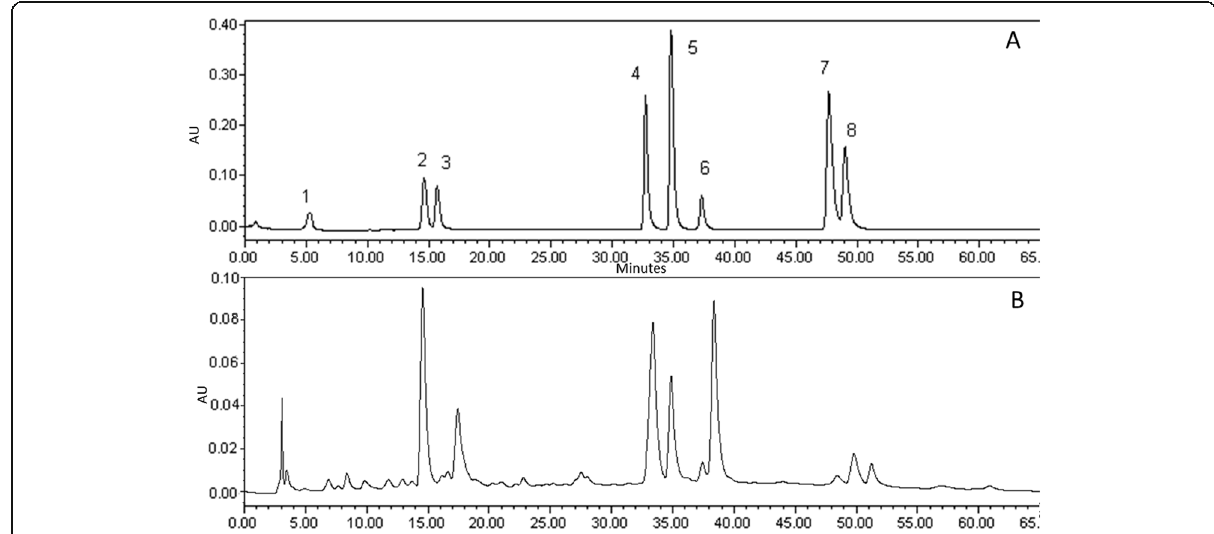
Fig. 1 HPLC chromatogram of the phenolic acids and flavonoids in the B. trimera aqueous extract at 254nm. The numbers in the chromatogram (A) correspond to the standards used (1: gallic acid; 2: chlorogenic acid; 3: caffeic acid; 4: rutin; 5: ellagic acid; 6: rosmarinic acid; 7: quercetin; and 8: